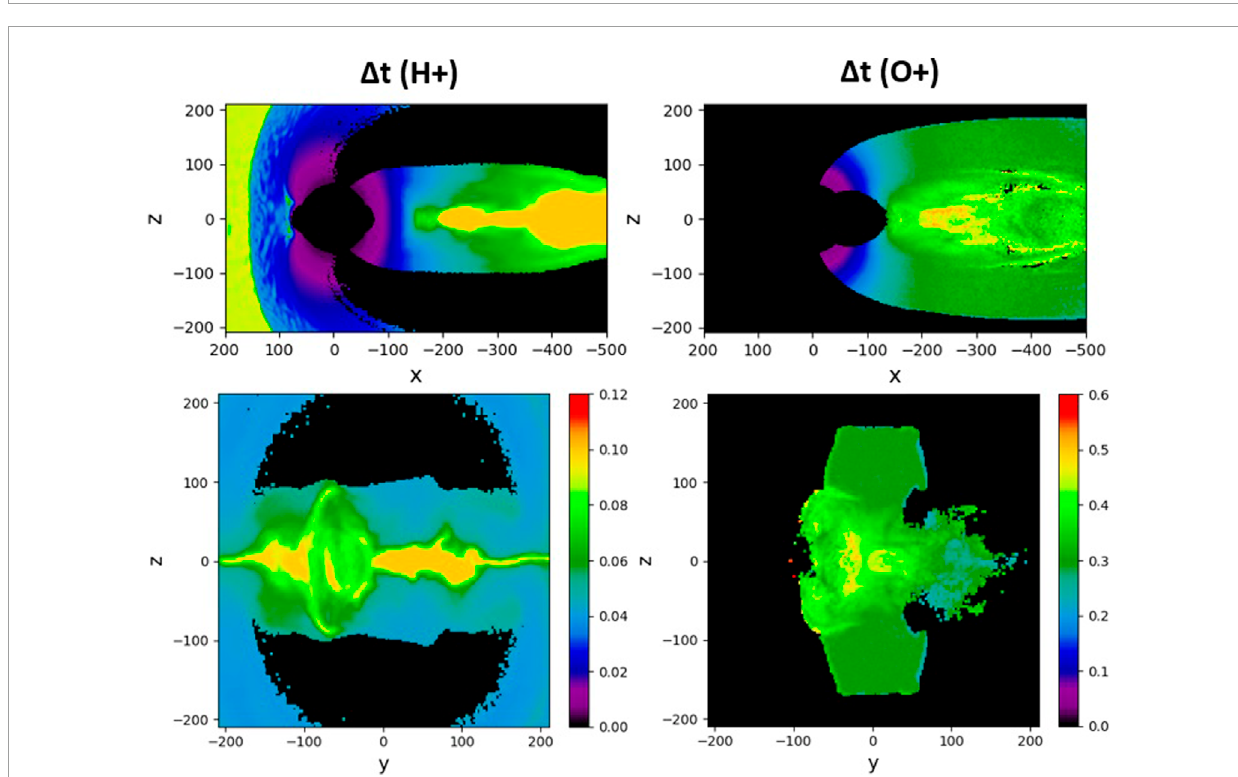
FIGURE 9 Cell-averaged H+ and O+ particle timesteps in two cross-sections in the first lobe outflow simulation at Ω cp t = 461: x–z ( y = 1 d i ) and y–z ( x = − 199 d i ) .